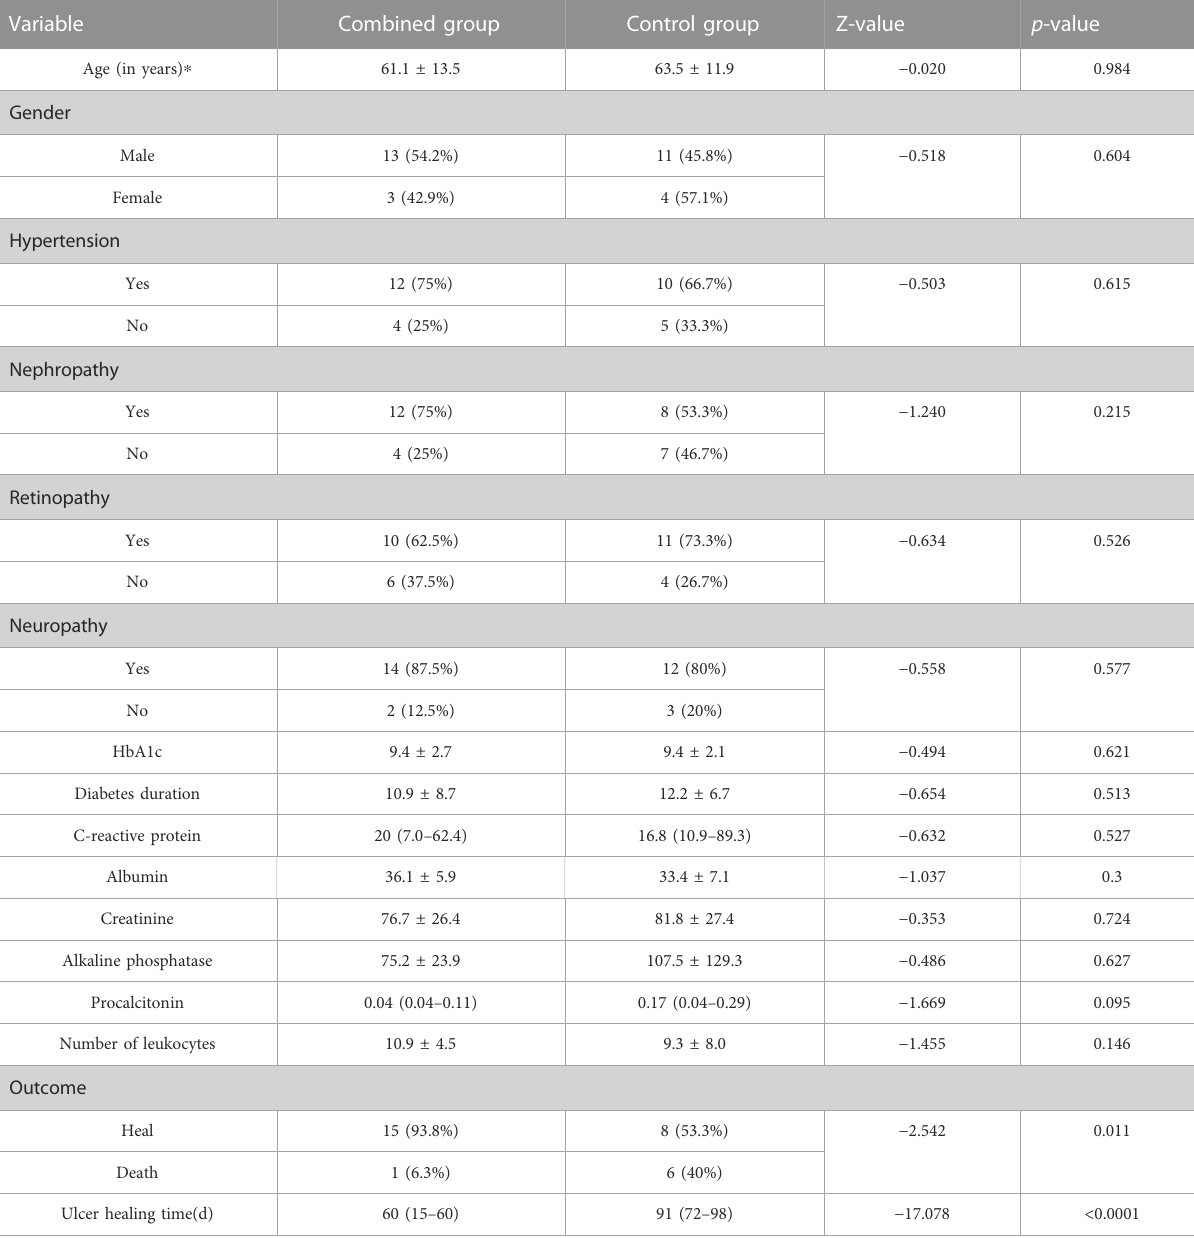
TABLE 5 Comparison of the combined group and control group, follow-up wound healing time, and outcome in the two groups. * p < 0.05, ** p < 0.01, and *** p < 0.001.